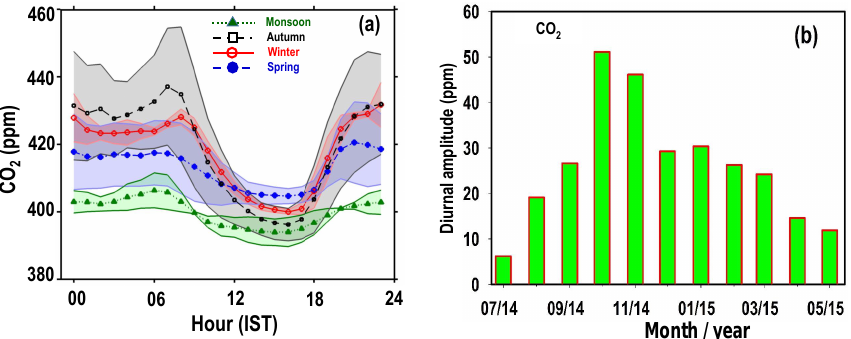
Figure 5. (a) Average diurnal variation of CO 2 over Ahmedabad during all four seasons. (b) Monthly variation of average diurnal amplitude of CO 2 during from July 2014 to May 2015. All times are in Indian Standard Time (IST), which is 5.5h ahead of Universal Time